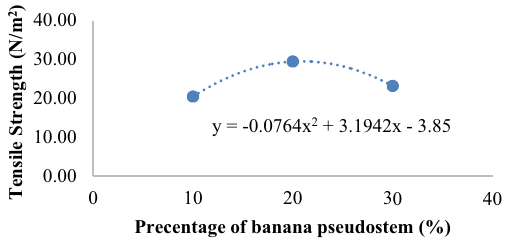
Fig. 2 The correlation between tensile strength and the percentage of banana pseudostem contents in organic mulch sheet